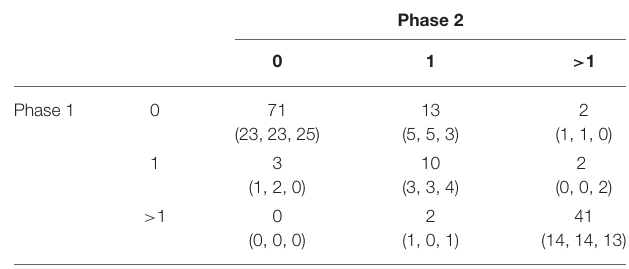
TABLE 8 | Contingency table of numbers of patients reported with no (0), one (1), or more than one ( > 1) lesion in the two phases of the